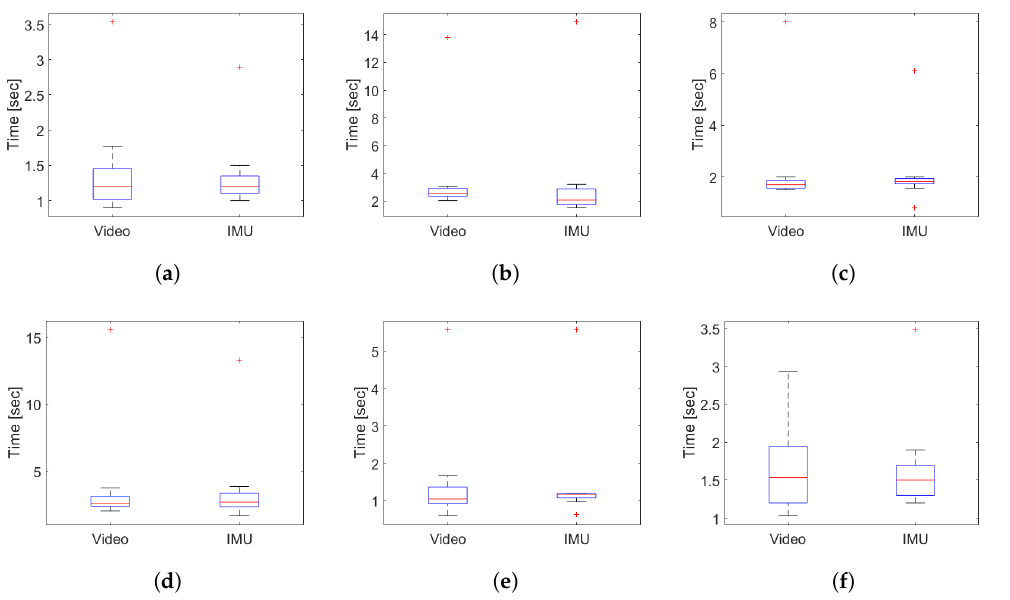
Figure 19. Distribution plots of the duration times obtained with the segmentation algorithm compared with the video analysis in the older adults group. ( a ) duration distribution for standing time; ( b ) duration distribution for the first walk time; ( c ) duration distribution for the 3-m turning; ( d ) duration distribution for the second walk time; ( e ) duration distribution for the pre-sitting turning time; ( f ) duration distribution for sitting time. Table 6. Average time duration and error from the IMU activities segmentation algorithm compared to the video analysis of the older adults